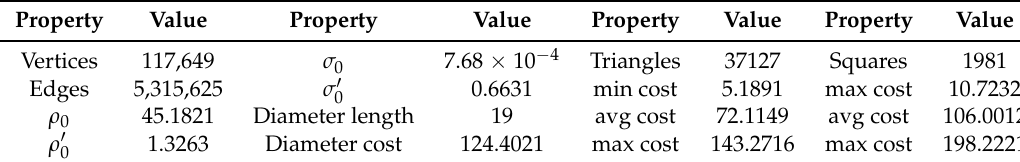
Table 2. Structural properties of graph Y .